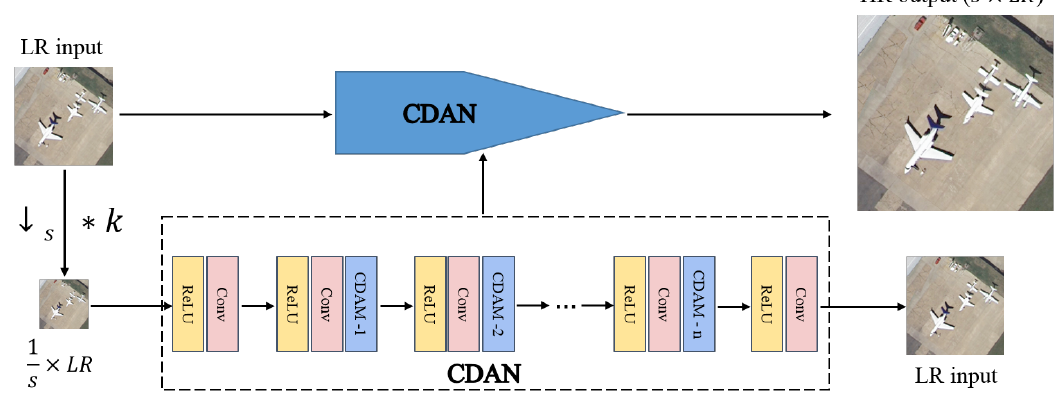
Figure 2. The overall structure of cross-dimension attention guided self-supervised remote sensing single-image super- resolution (CASSISR). Among them, CDAM is the proposed cross-dimension attention module.